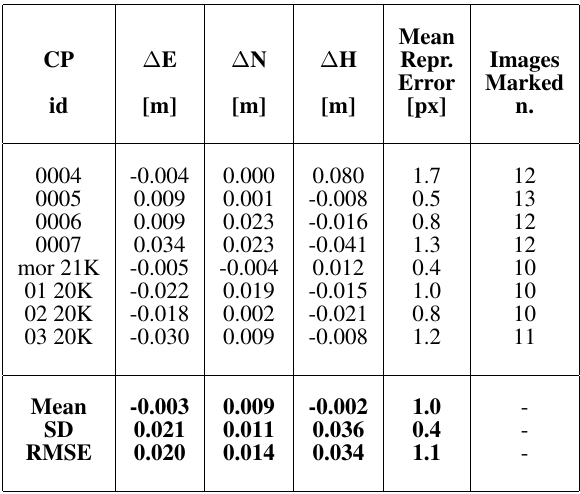
Figure 6. UAV tracks and target distribution - 2021 block.